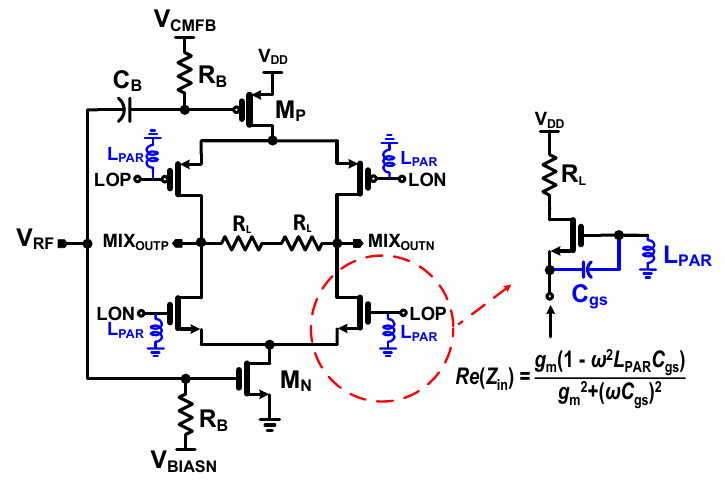
Figure 7. Schema of single-balanced